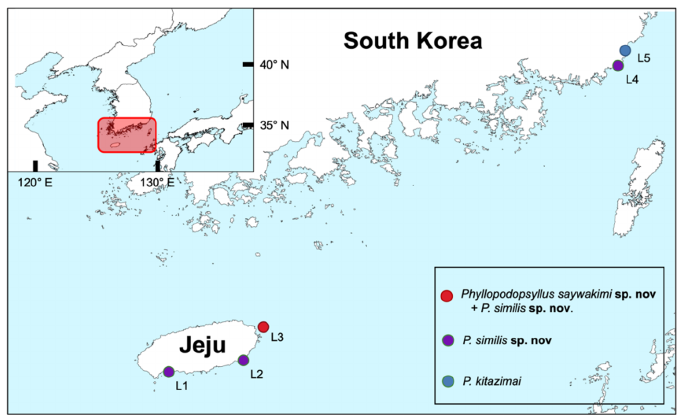
Figure 1. Map showing the localities of collecting specimens of Phyllopodopsyllus saywakimi sp. nov. , P. similis sp. nov. , and P. kitazimai . The red dot indicates the type locality of both new species; the purple and blue dots mark the locations where only P. similis sp. nov. and P. kitazimai were collected, respectively. This map was made under QGIS (3.22, downloaded from https://qgis.org/en/site/ forusers/download.html) using map data of GADM (4.1, downloaded from